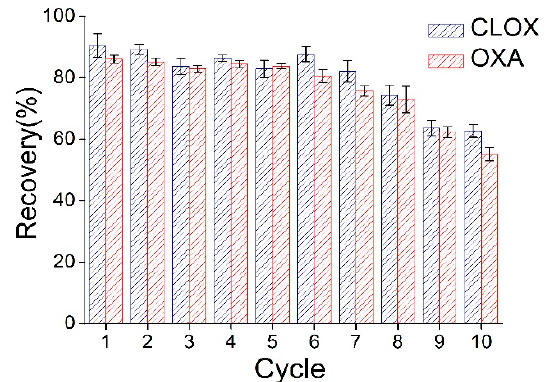
Figure 10. Reusability study: recovery of two β -lactams depending on the number of cycles of adsorption–desorption. Conditions: the amount of PPy-PA6-NFsM, 10.0 mg; sample volume, 40.0 mL; concentration of two analytes, 0.5 μ g/mL; pH, 4.0; eluent, 2.0 mL of 2% ammonia in acetonitrile ( v / v ); desorption time, 30 min.